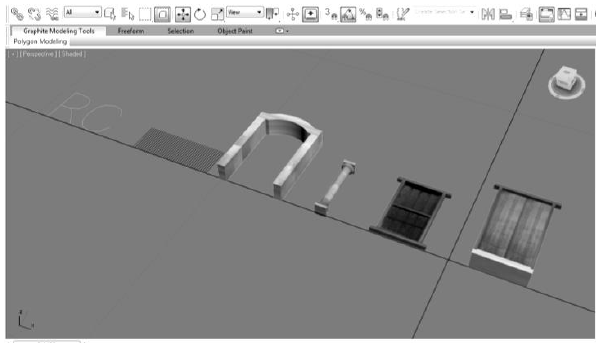
Figure 6. Colonial elements displayed as RailClone